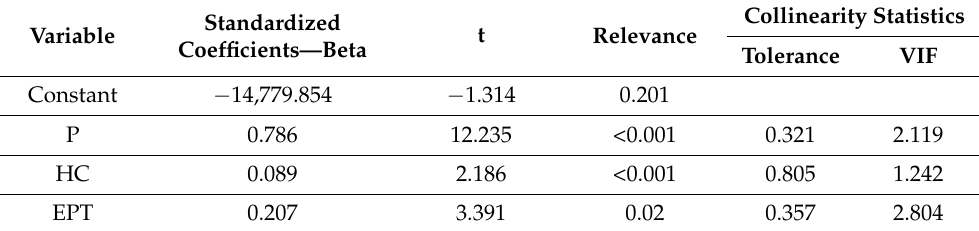
Table 11. Coefficients in the regression model of greenhouse gas emissions in